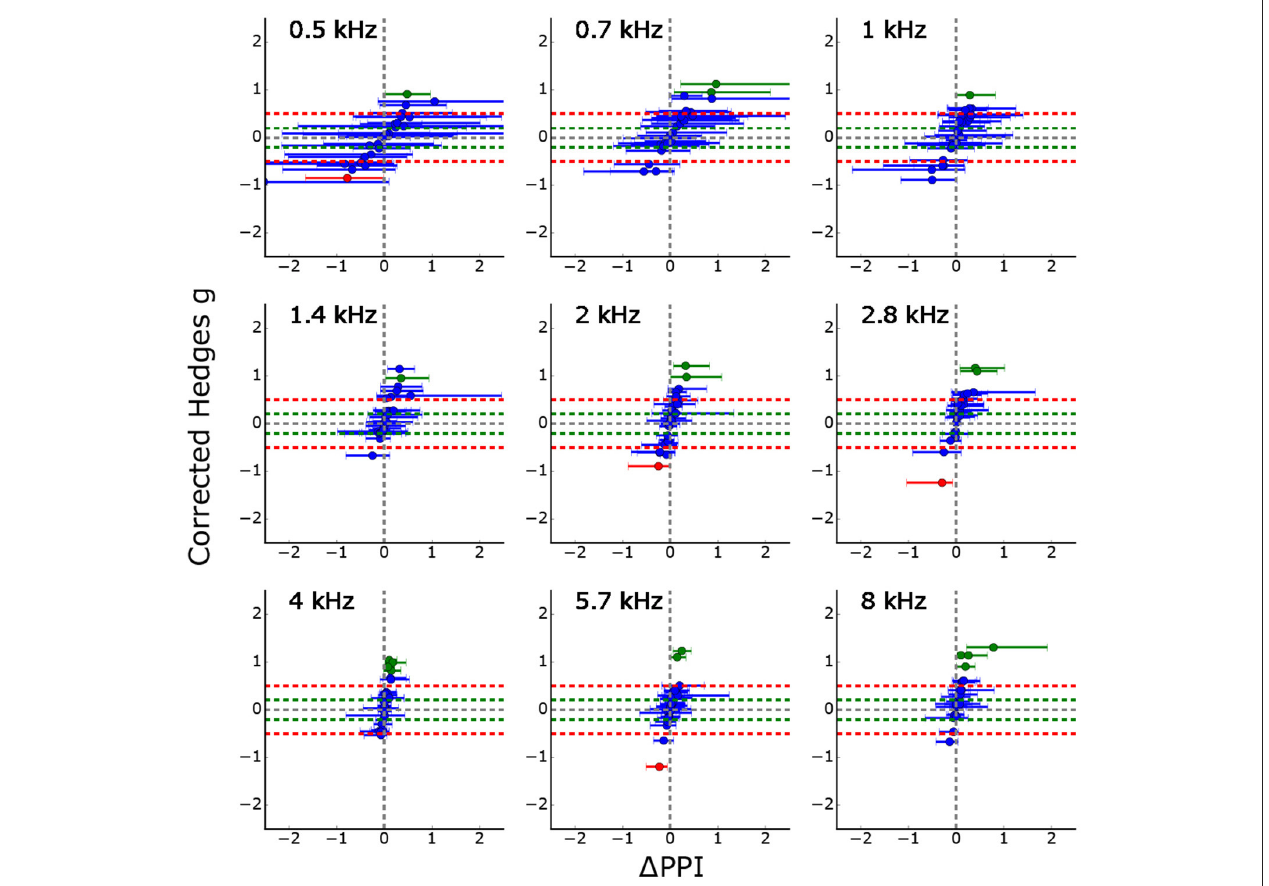
FIGURE 5 | Corrected effect size as a function of the median 1 PPIs for all 26 animals (error bars: quartiles). Significant PPI decrease (based on Welch-Test cf. section GPIAS statistics, p < 0.05) is marked in red whereas significant PPI increase is marked in green. Trivially, the effect size and the median 1 PPI are highly correlated, but the effect size is additionally normed by the standard deviation of the logarithmized ASR amplitude ratio distributions. The figure shows that only three PPI changes become significantly smaller (red) for all 26 animals and 9 stimulus frequencies